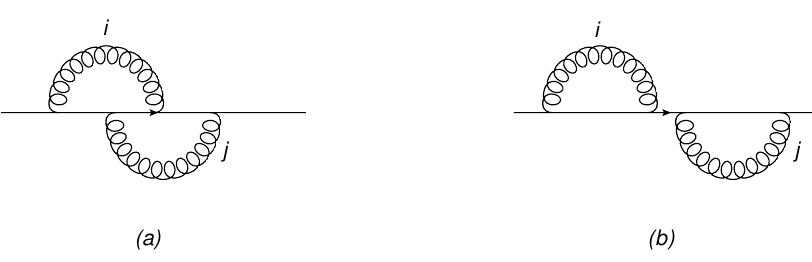
Figure 6 . ( a ) Generalised self-energy diagram on a single Wilson line, with replica indices i and j ; ( b ) replica ordered version, if i < j